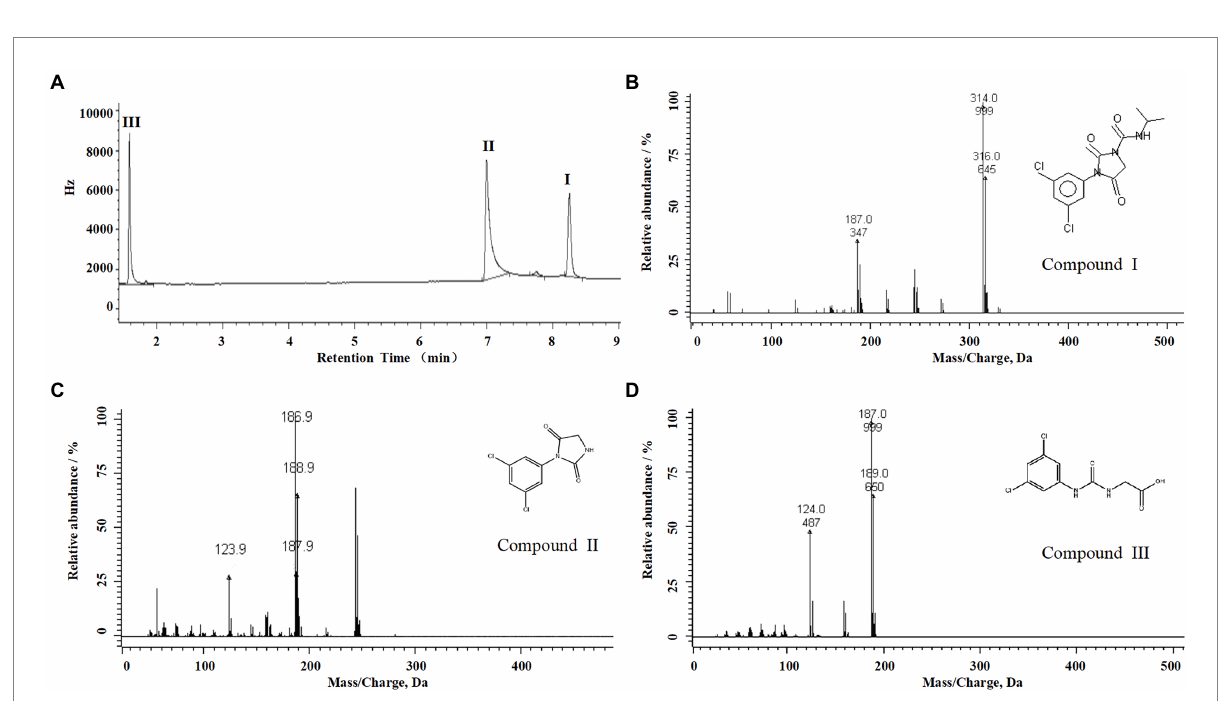
FIGURE 6 Degradation pathway of iprodione in Azospirillum sp. A1-3. (A) GC analysis of metabolites that appeared during the degradation of iprodione by strain A1-3, (B) MS/MS analysis of compound I, (C) MS/MS analysis of compound II, and (D) MS/MS analysis of compound